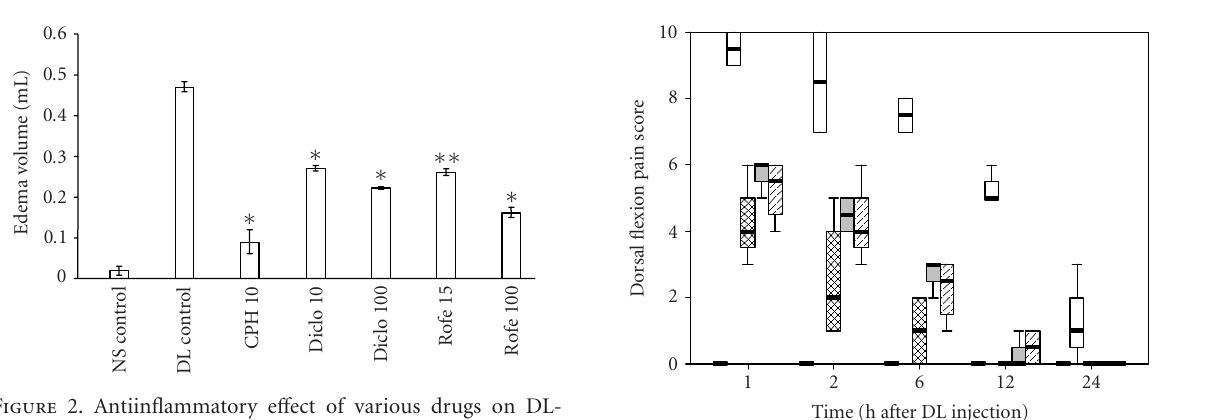
Figure 2. Antiinflammatory e ff ect of various drugs on DL- induced paw edema. Edema was induced by injecting 0 . 1mL of 1% solution of DL into subplantar surface of right hind paw. The drugs were administered orally 1 hour before inject- ing DL. Edema volume was measured at 2hours ( n = 6). CPH 10-cyproheptadine 10 mg/kg; Diclo 10-diclofenac 10 mg/kg; Di- clo 100-diclofenac 100 mg/kg; Rofe 15-rofecoxib 15 mg/kg; Rofe 100-rofecoxib 100mg/kg; ∗ P < . 01 and ∗∗ P < . 05 versus DL control.